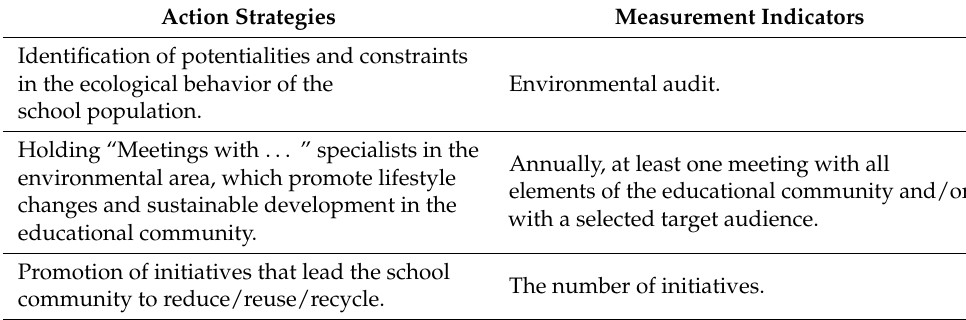
Table 3. Sustainability, health and well-being strategies and measurement indicators.